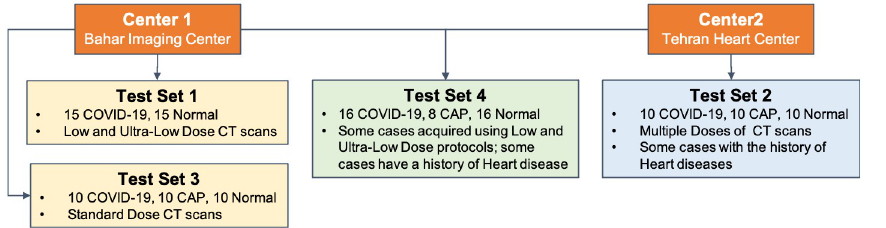
Fig 1. Overview of the SPGC-COVID dataset used in this